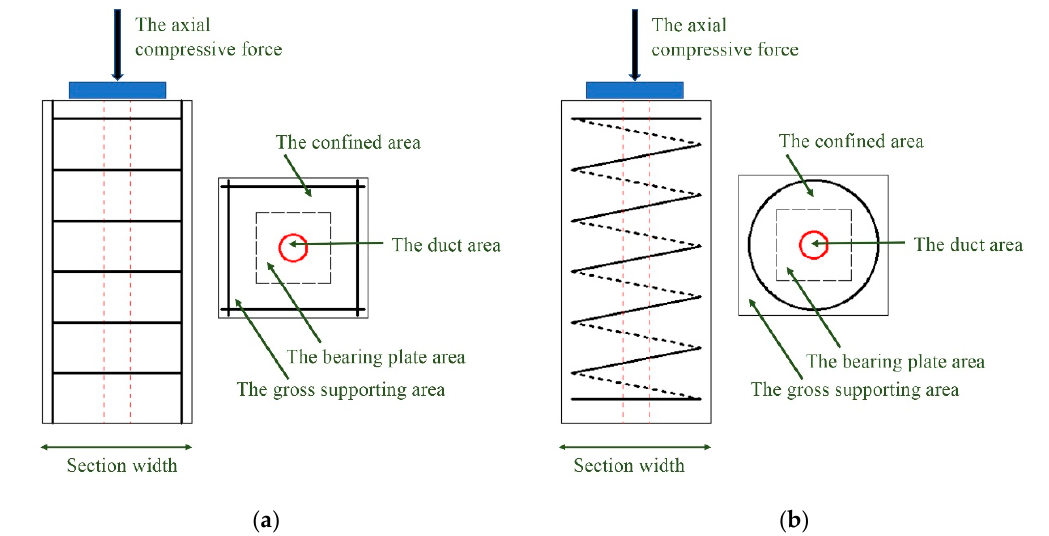
Figure 2. The RC columns considered in this research (adapted from [20]): ( a ) Confined columns with ties; ( b ) Confined columns with spirals.